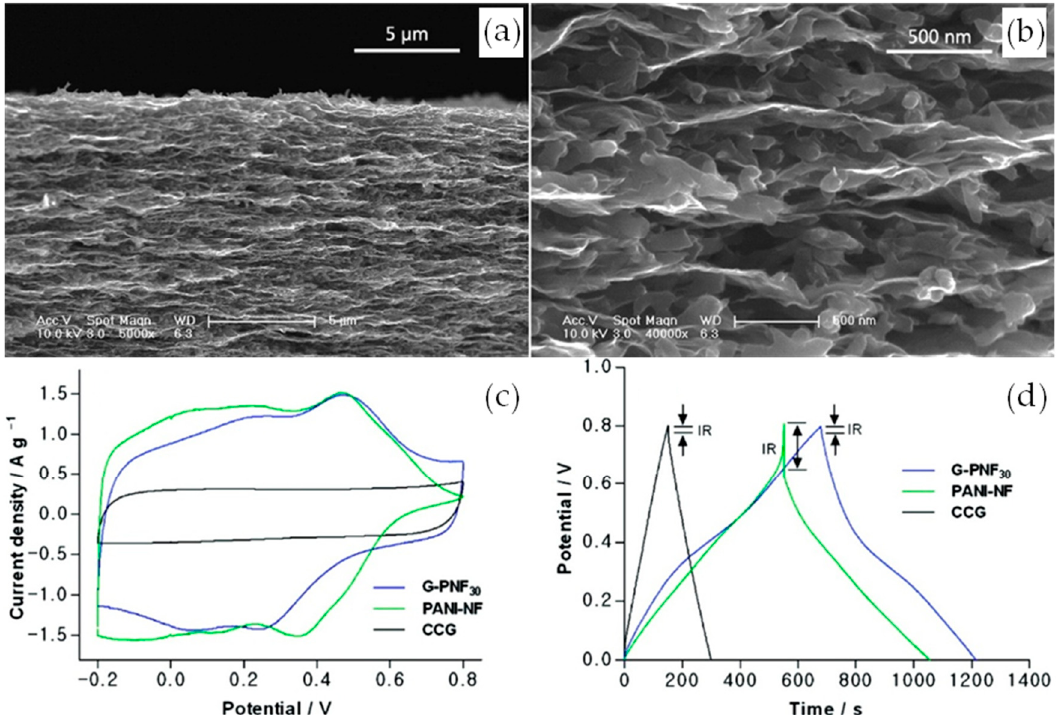
Figure 1. ( a , b ) Cross-sectional SEM images of G-PNF 30 ; ( c ) CV curves of supercapacitors based on G-PNF 30 , as-formed PANI-NF, and CCG films; ( d ) GCD curves of the supercapacitors based on G-PNF 30 , as-formed PANI-NF, and CCG films. Reproduced with permission from [47]. American Chemical Society (2010).